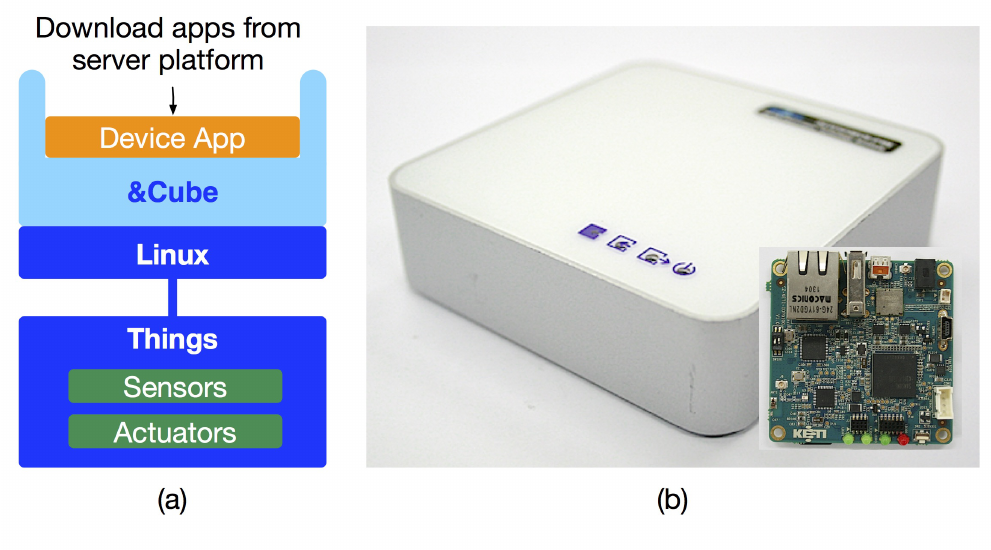
Figure 3. The &Cube and IoT gateway: ( a ) architecture of our device software platform (&Cube) and ( b ) the IoT gateway developed (IoTG100) on which the &Cube is